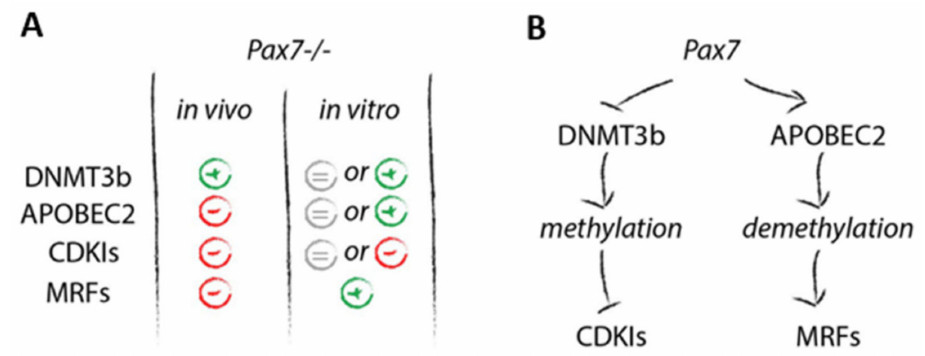
Figure 7. PAX7, DNMT3b, APOBEC2, CDKIs and MRFs in in vitro differentiating ESCs and iPSCs and in vivo developing teratomas. ( A ) Changes in the expression of selected markers in Pax7 − / − cells in relation to Pax7 +/+ cells. + higher level; − lower level; = significant difference was not observed. ( B ) Schematic diagram presenting status quo in wild type, i.e., Pax7 +/+